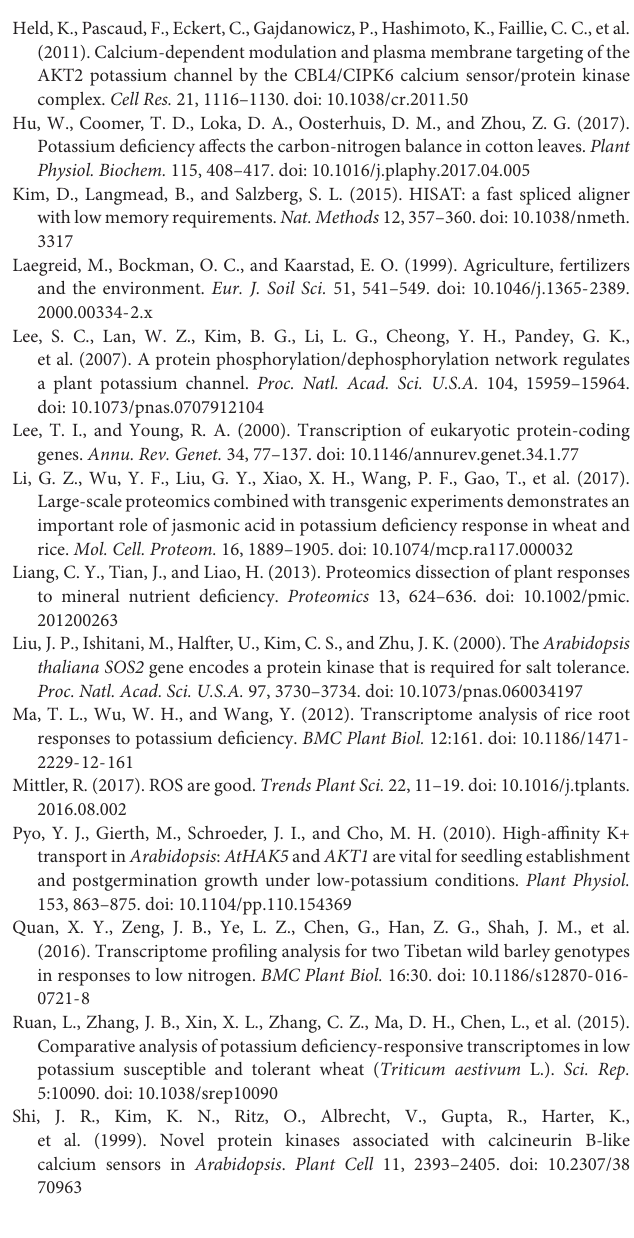
Supplementary Table 9 | Genes encoding glutathione S-transferase that were differentially expressed between genotypes under low-K stress conditions. “–” indicates no significant difference in gene expression. Supplementary Table 10 | Transcription factors (TFs) identified among the differentially expressed genes. Supplementary Table 11 | Transcription factors (TFs) that satisfied the screening criteria. The screening criteria was as follows: up-regulated in KN9204, but unchanged/down-regulated in BN207 or unchanged in KN9204, but down-regulated in BN207. “–” indicates no significant difference in gene expression. Supplementary Table 12 | Fold-changes in the contents of detected metabolites in the roots of the two wheat genotypes under low-K stress conditions. “–” indicates no significant difference in